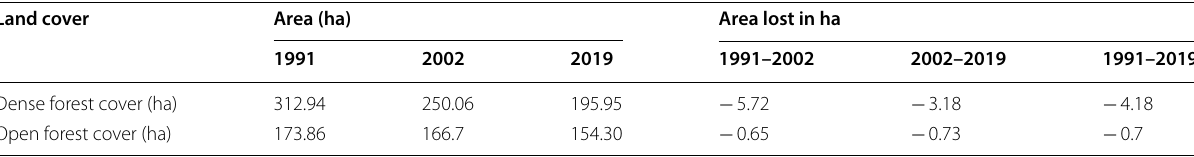
Table 8 Annual rate of forest cover change Land cover